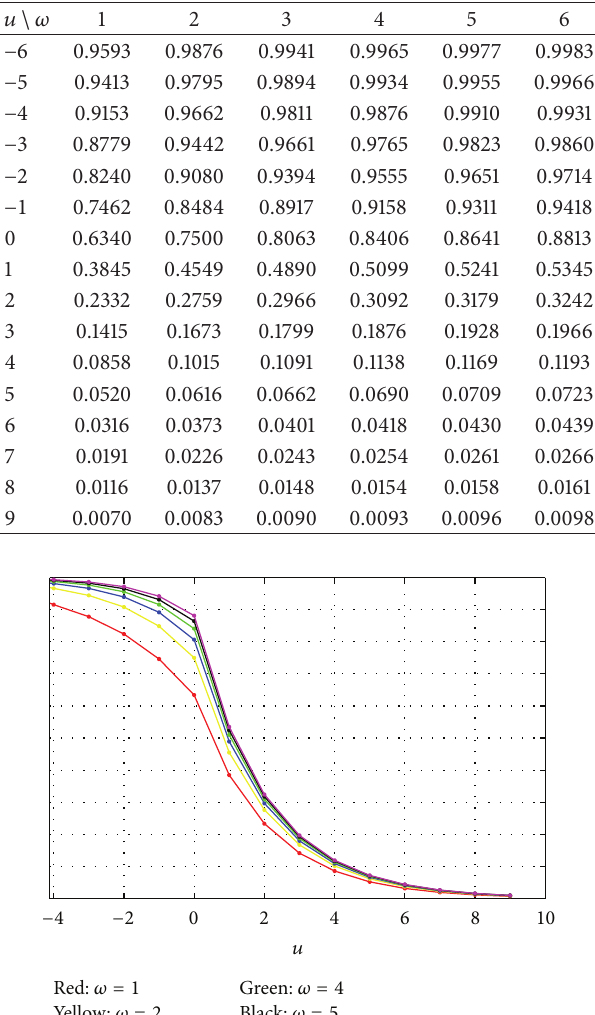
Figure 2: The expected sum of discounted dividend 𝑉(𝑢,𝑏) when 𝜔 = 1 .